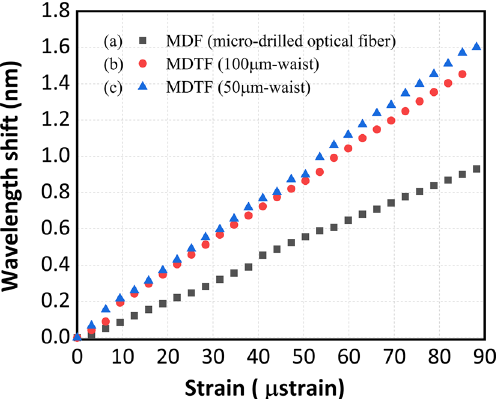
Figure 12. Wavelength shift as a function of strain change when using ( a ) a MDF, ( b ) a MDTF with 100 μm-waist, and ( c ) a MDTF with 50 μm-waist.